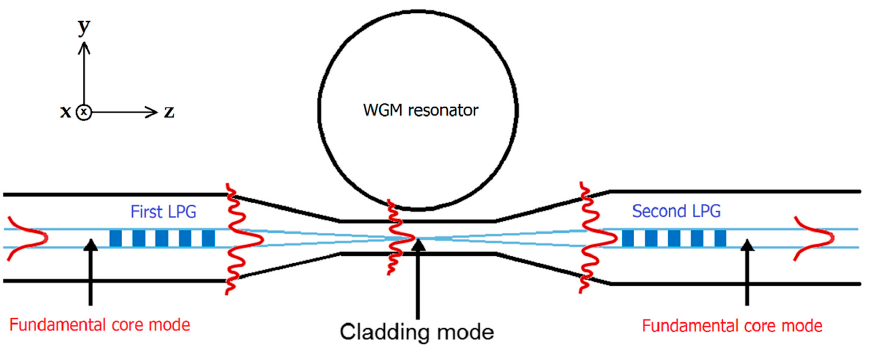
Figure 1. Sketch of the coupling principle of an optical whispering gallery mode (WGM) microresonator by means of a tapered fiber in between two identical long period gratings (LPGs).